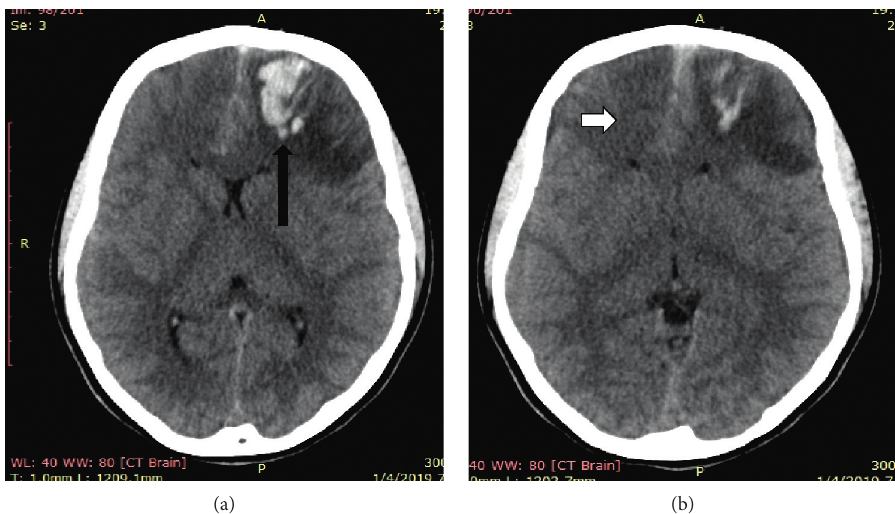
Figure 1: Noncontrast CT brain at presentation, indicating (a) haemorrhagic infarction in the left frontal lobe (black arrow) and (b) focal cerebral oedema in the right frontal lobe (white